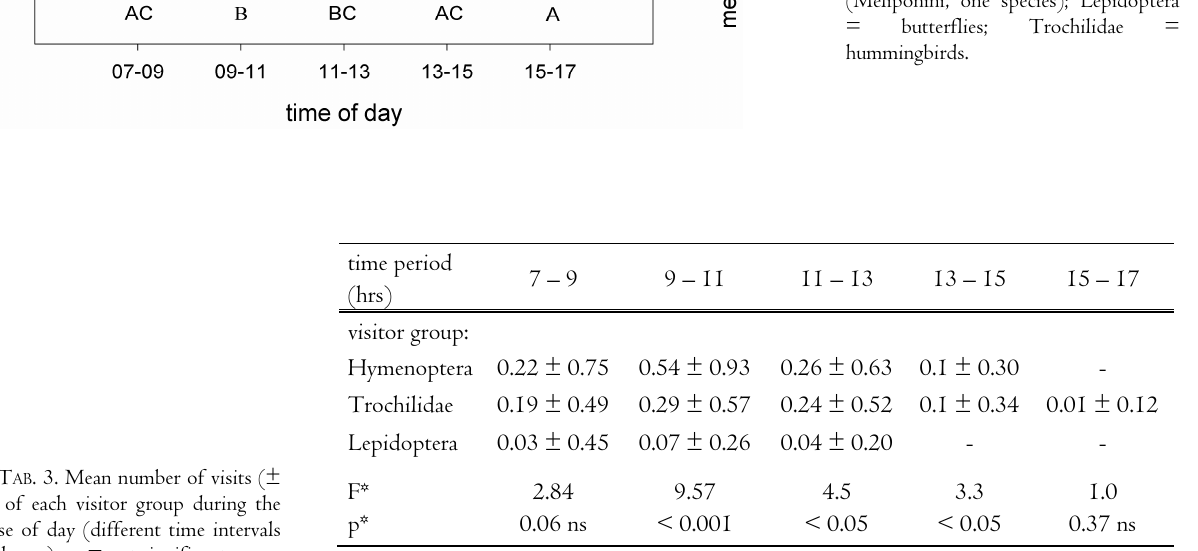
F IG . 2. Boxplots (corresponding to left y-axis) showing the total number of floral visits per flower per 2 x 2m observation plot to H. angusta at different times of day (number of 20 min observation units was 72 for each time span; dots, outliers within 5th and 95th percentiles). Box-plots with equal letters do not differ significantly from each other (ANOVA testing). Curves (corresponding to right y-axis) show the mean number of floral visitors per group. Trigona = stingless bees (Meliponini, one species); Lepidoptera = butterflies; Trochilidae =